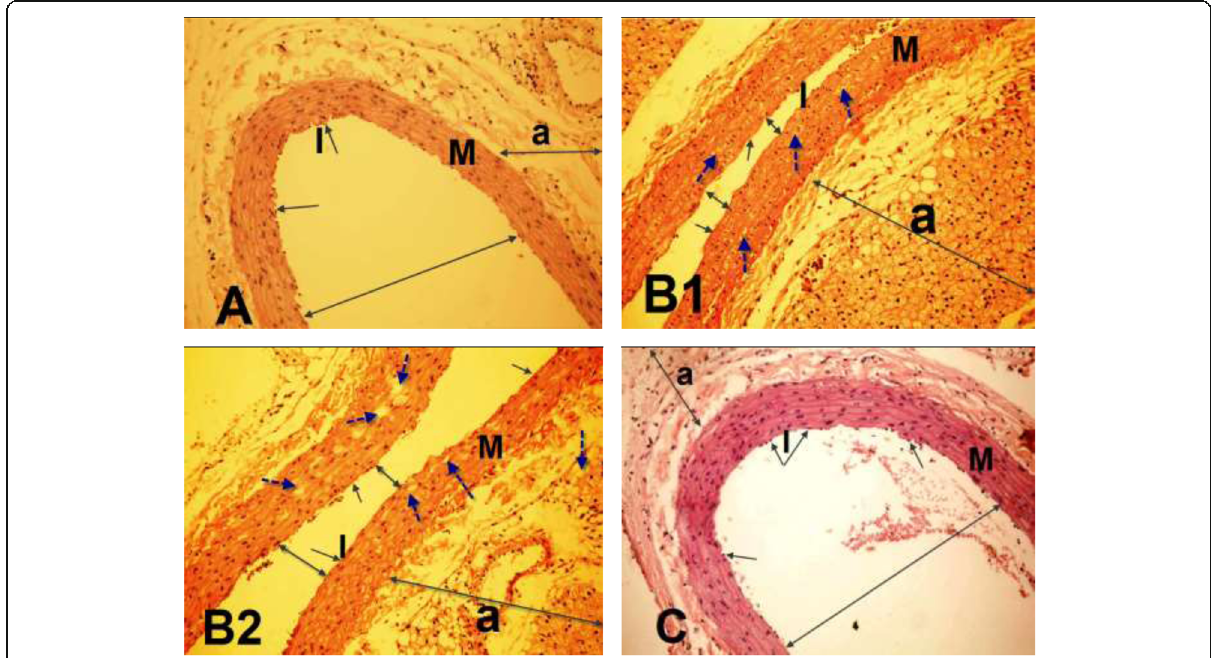
Fig. 2 Light micrographs of dorsal aorta of rats treated as follow: control ( A ), triton-treated rats ( B1, B2 ), and triton + soybean oil-treated rats ( C ). Note: normal tunica intimal (I) with a single irregular layer of endothelial cells (black-arrows), tunica media (M) with elastic fibers and tunica adventitia (a) appear normal in control group. Loss of endothelial cells of tunica intimal (I), disorganized and vacuolation of tunica media (M), increased adventitial thickness (a), and decreased the lumen of the aorta (double headed arrows) in triton-treated rats ( B1, B2 ) compared to normal layers of the dorsal aorta in the control group ( A ). Histological changes induced after triton treatments were markedly reduced in the